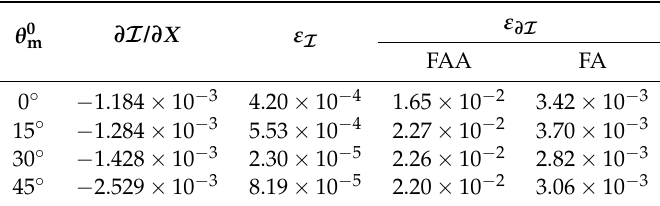
Table 4. Partial derivative ∂ I / ∂ X , and the relative errors ε I and ε ∂ I for different values of the detector zenith angle θ 0 m . The results correspond to the solar azimuthal angle ϕ 0 = 0 ◦ and are computed with the linearized forward-adjoint approach (FAA) and the linearized forward approach (FA).